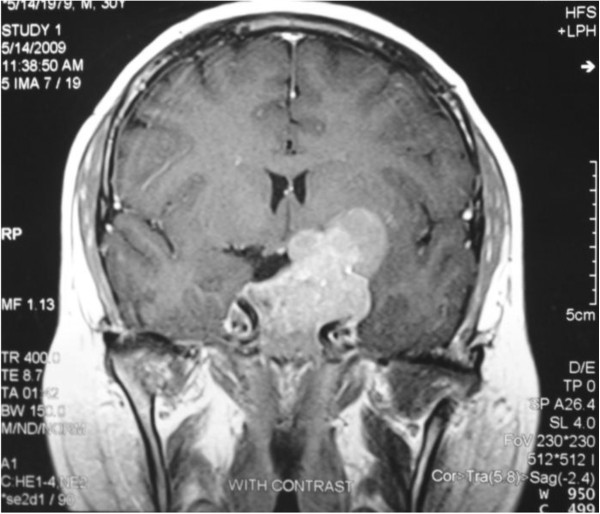
Huge macroprolactinoma with suprasellar invasion before treatment.